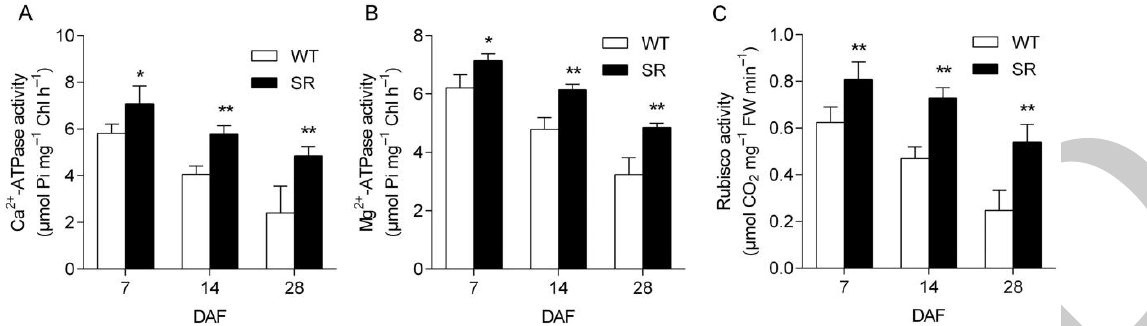
Figure 6. Higher activities of Ca 2+ -ATPase, Mg 2+ -ATPase, and Rubisco and content of Rubisco in SR during senescence. ( A – C ) Ca 2+ -ATPase ( A ), Mg 2+ -ATPase ( B ), and Rubisco ( C ) activities of WT and SR. Values ( A – C ) are given as means ± SD ( n = 3). Asterisks indicate significant differences between WT and SR. * p < 0.05; ** p < 0.01 compared with WT by Student’s t -test.